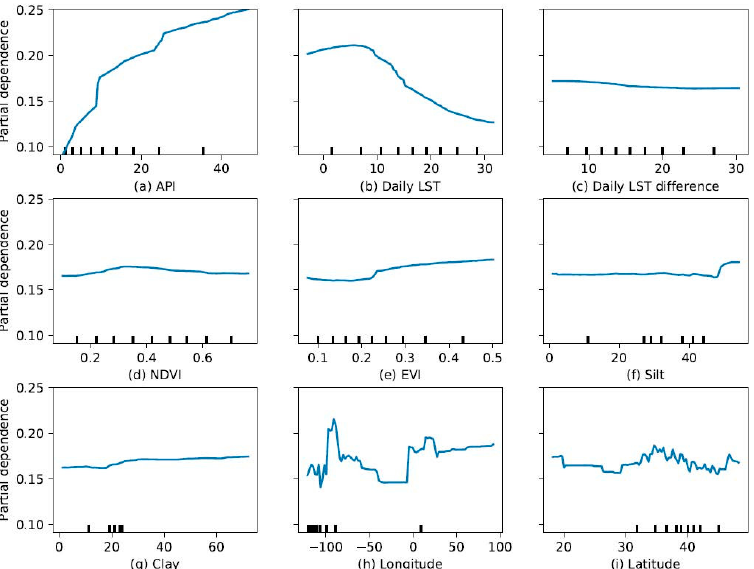
Figure 11. Partial dependence plot of surface soil moisture on the predictor variables computed based on the RF model: ( a ) Antecedent Precipitation Index; ( b ) Daily LST; ( c ) Daily LST difference; ( d ) Normalized Difference Vegetation Index (NDVI); ( e ) Enhanced Vegetation Index (EVI); ( f ) Silt content; ( g ) Clay content; ( h ) Geographic coordinates (Longitude); ( i ) Geographic coordinates (Latitude).